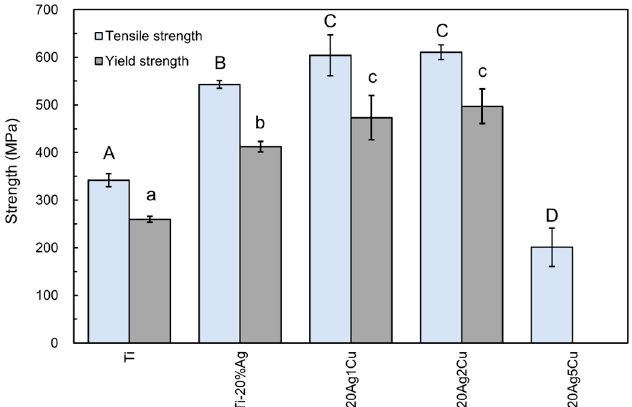
Figure 5. Tensile and yield strengths of the Ti-Ag-Cu alloys. Identical letters indicate a statistically insignificant difference ( p > 0.05).